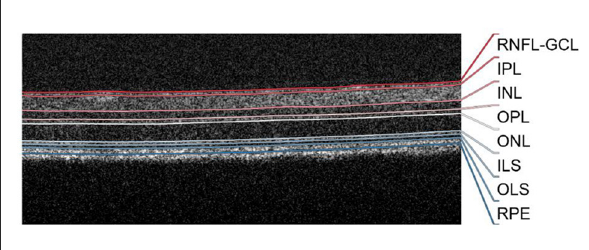
FIGURE1 Representative B-scan with overlayed segmentation. RNFL-GCL, retinal nerve fiber layer and ganglion cell layer complex; IPL, inner plexiform layer; INL, inner nuclear layer; OPL, outer plexiform layer; ONL, outer nuclear layer; ILS, photoreceptor inner segments; OLS, photoreceptor outer segments; RPE, retinal pigment epithelium; TRT, total retina